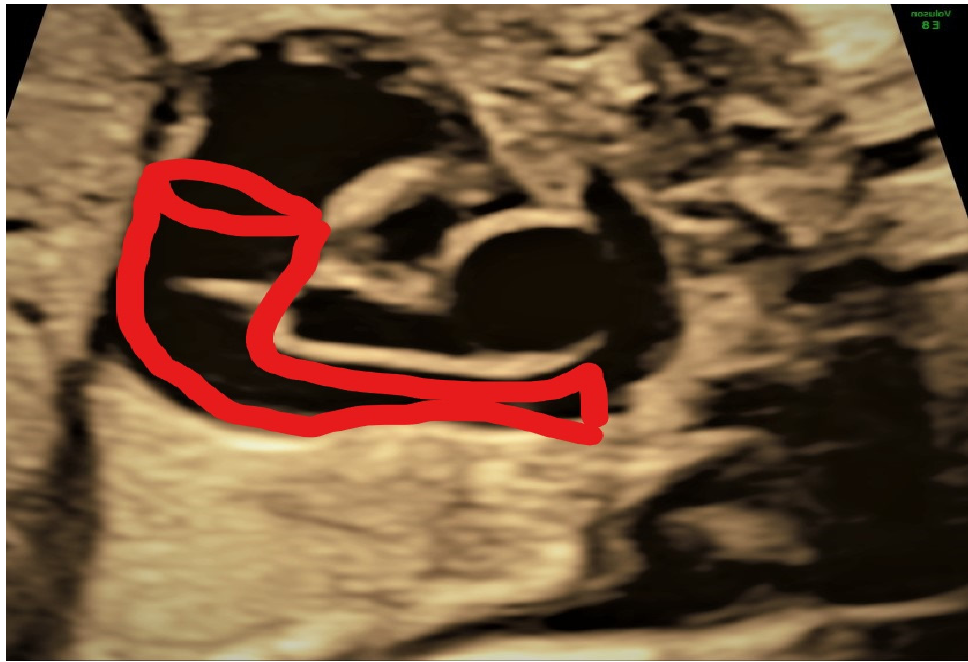
Figure 3. Sagittal section depicting the pipeline aspect of the persistent left superior vena cava (PLSVC).